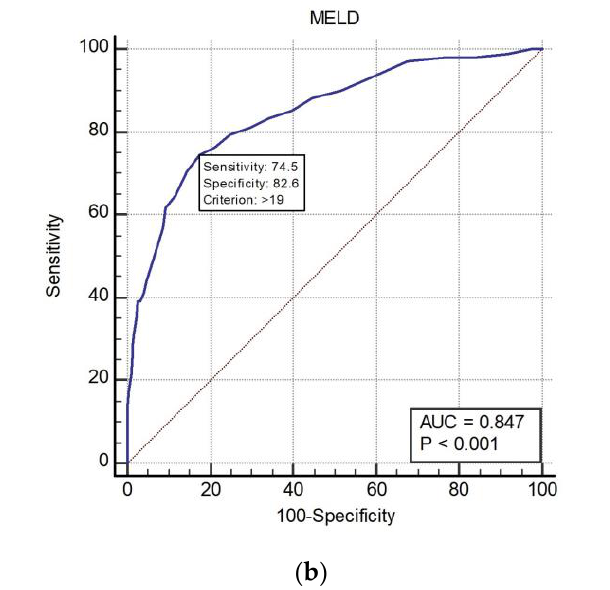
( d ) Figure 1. Receiver operating characteristic curves (ROC) and area under the ROC (AUROC) of pa- tients with total cirrhosis for 1 - month mortality. ( a ) CP score for 1 - month mortality, 0.831 (95% confidence interval [CI], 0.809–0.851); ( b ) MELD for 1 - month mortality, 0.847 (95% CI, 0.826–0.867); ( c ) MELD - GRAIL - Na for 1 - month mortality, 0.857 (95% CI, 0.836–0.876); ( d ) comparison of AUROC for 1 - month mortality between the CP, MELD, and MELD - GRAIL - Na scores. 3.5.2. Three - Month Mortality The AUROCs of the CP, MELD, and MELD - GRAIL - Na scores for 3 - month mortality are shown in Figure 2a–c, respectively. The AUROC of the CP score was 0.837 ( p < 0.0001), that of MELD was 0.827 ( p < 0.0001), and that of MELD - GRAIL - Na was 0.835 ( p < 0.0001). A comparison of the AUROCs is shown in Figure 2d. There were no significant differ- ences in the 3 - month mortality prediction between the CP, MELD, and MELD - GRAIL - Na scores.